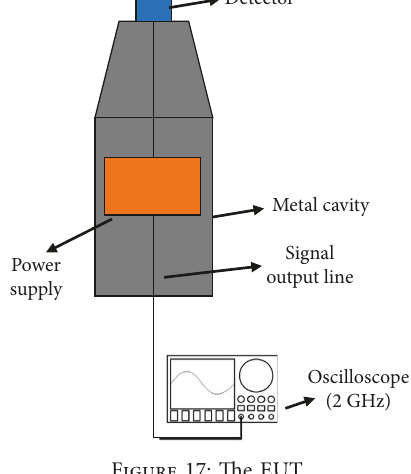
Figure 15: Coupling voltage at sensitive